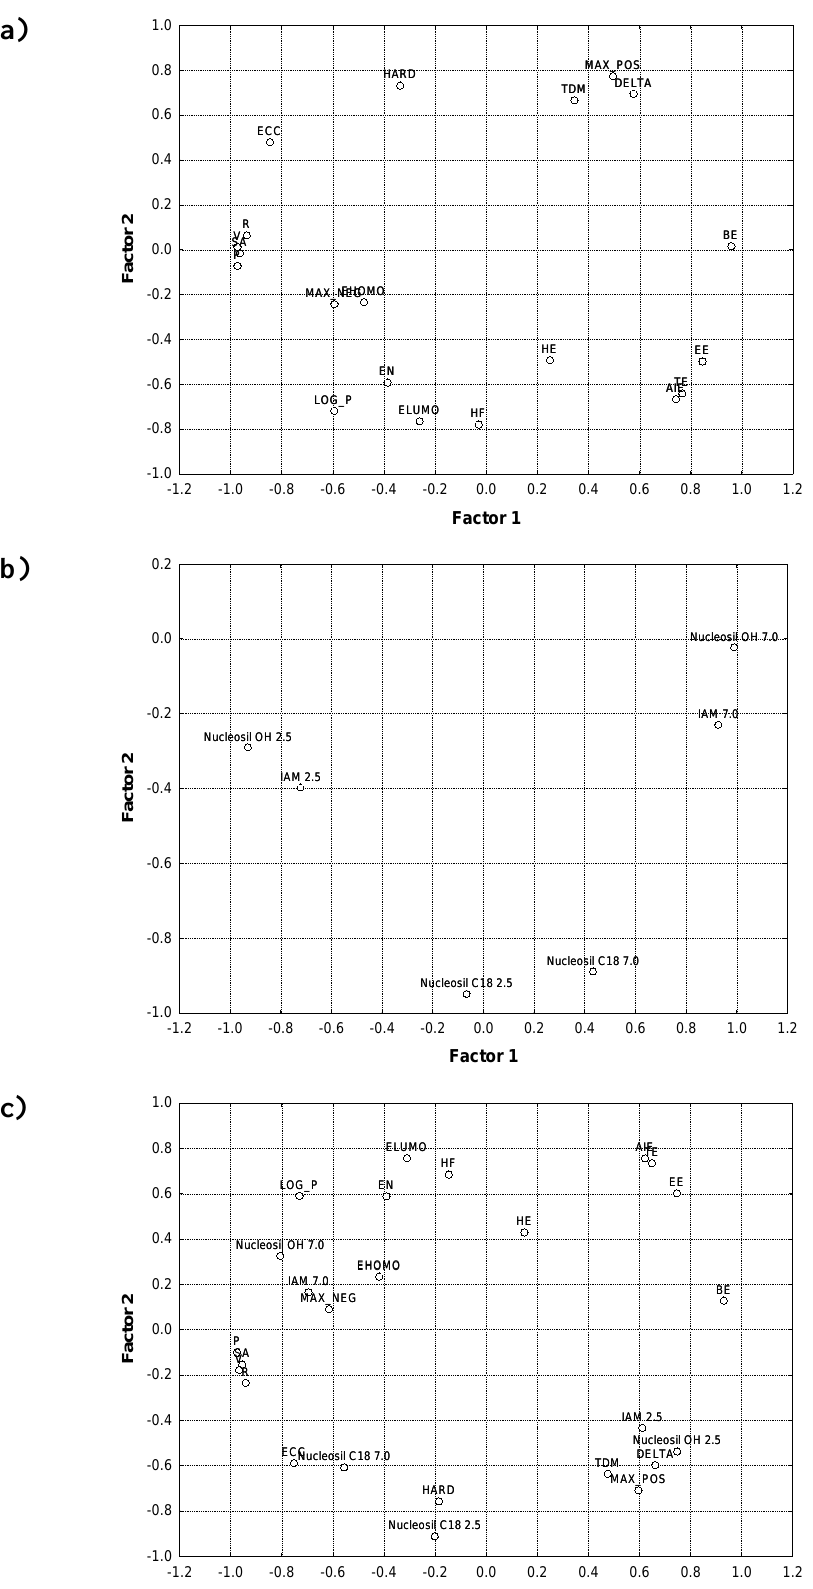
Figure 2. Two-dimensional scatter plots of the loadings of the first two factors: a) by structural parameters, b) by HPLC retention data, c) by structural parameters along with HPLC retention